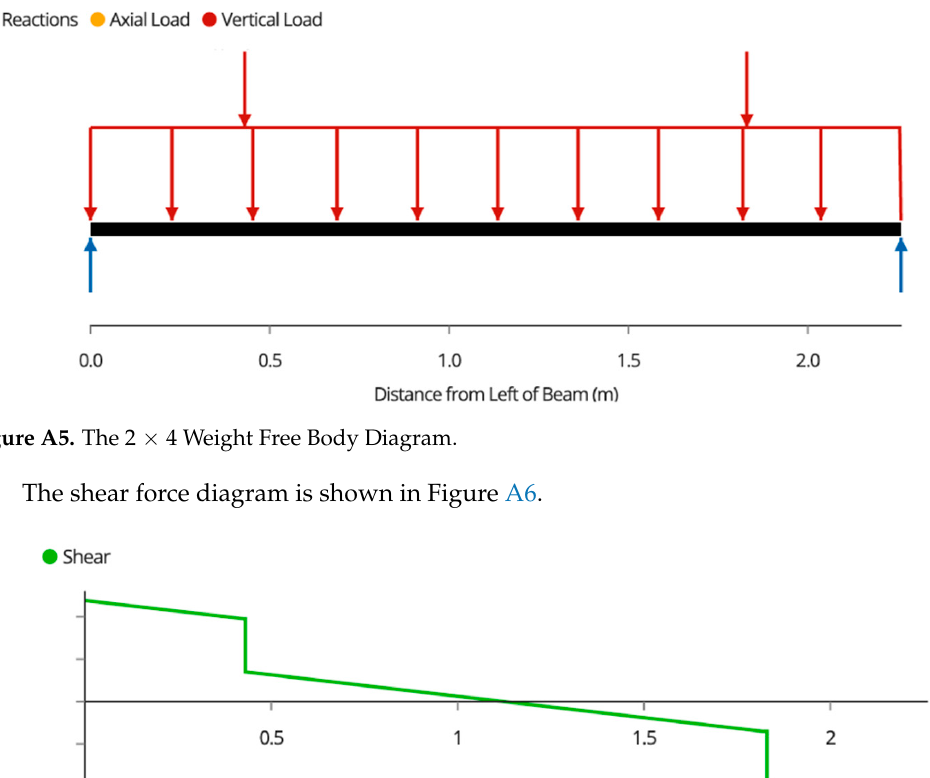
On the strong axis of each 2 × 4, the self-weight and the weight of two modules must be carried. This loading can be modelled with a uniform distributed self-weight, and the two point loads from the weight of the modules are as shown in Figure A5.